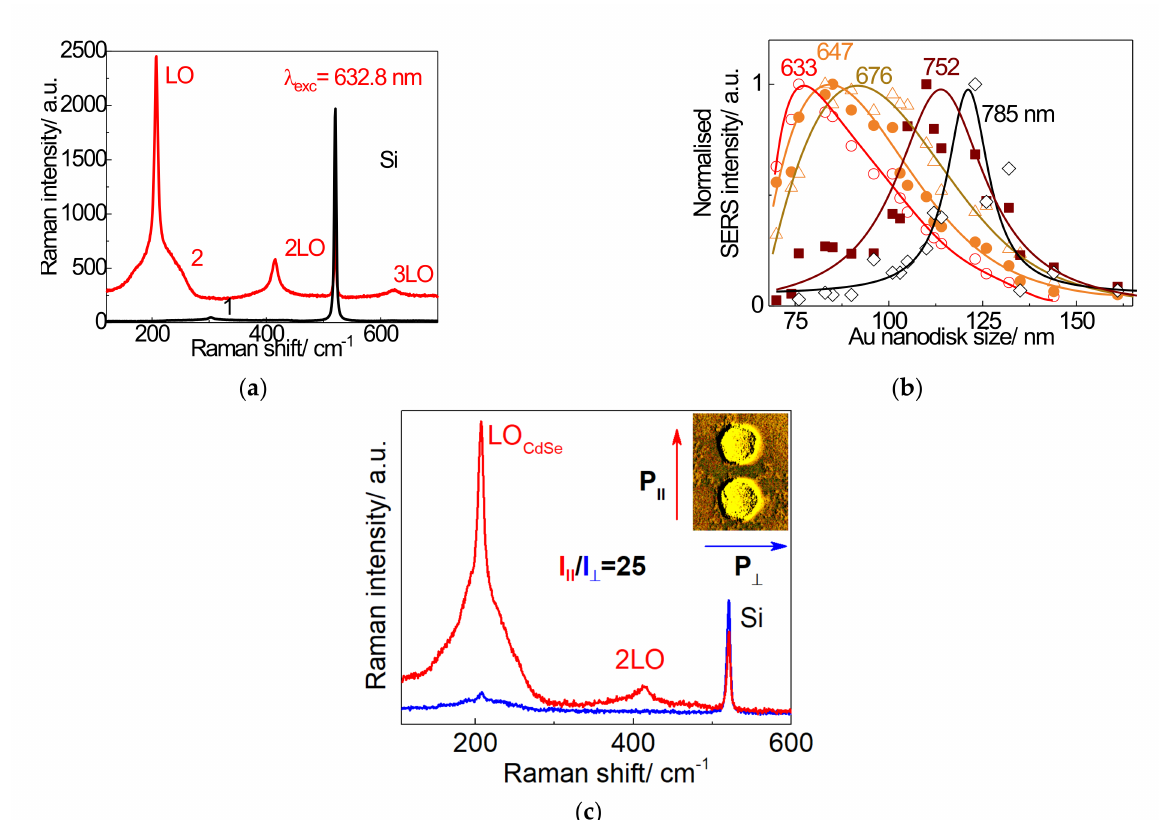
Figure 9. ( a ) Raman spectrum of CdSe NCs on bare Si (black spectrum 1) and resonant SERS spectrum measured on Au nanodisks arrays with diameters of 76 nm and 200 nm pitch between disks (spectrum 2), with an excitation wavelength of 632.8 nm. ( b ) The relative intensity of SERS by LO phonons as a function of Au nanodisk size (SERS profile) measured for 633, 647, 676, 752, and 785 nm excitation wavelengths. Solid lines represent polynomic fits. ( c ) Polarized SERS spectra of CdSe NCs on a dimer array, measured the polarization along (red spectrum) and across (blue spectrum) the dimer axis as shown in the insert. Adapted with permission from [41]. Copyright 2016,